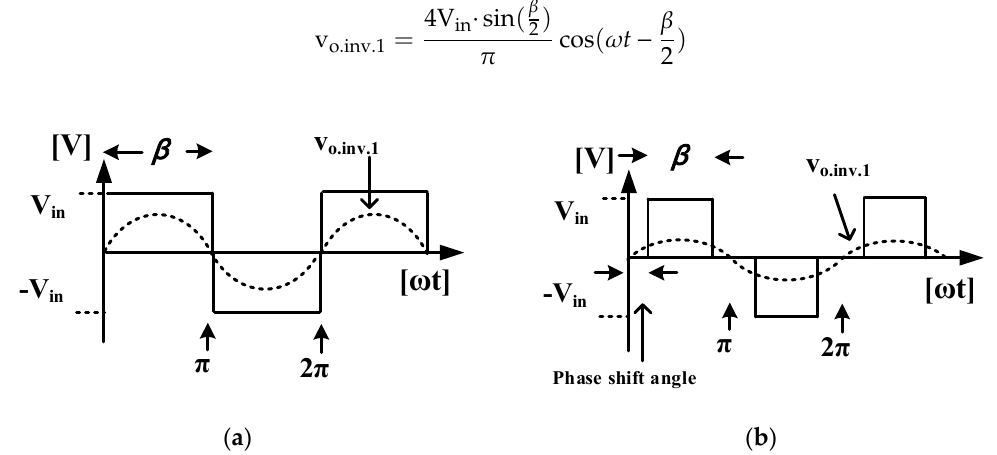
Figure 3. Conceptual diagram of control method considering plasma drop-out: ( a ) full output current condition and ( b ) decreasing output current.